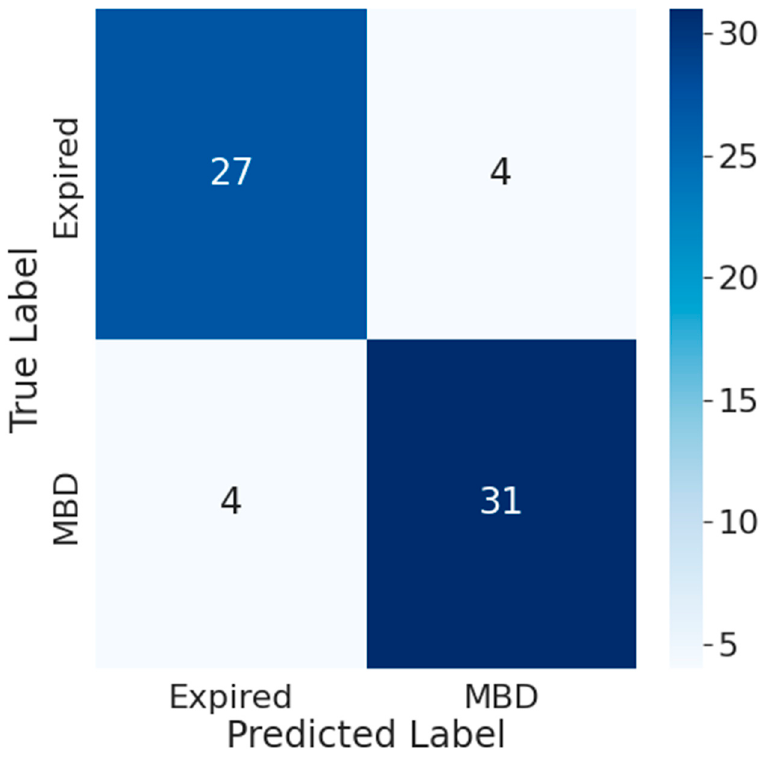
Figure A15. LSTM model confusion matrix using the wearable data.